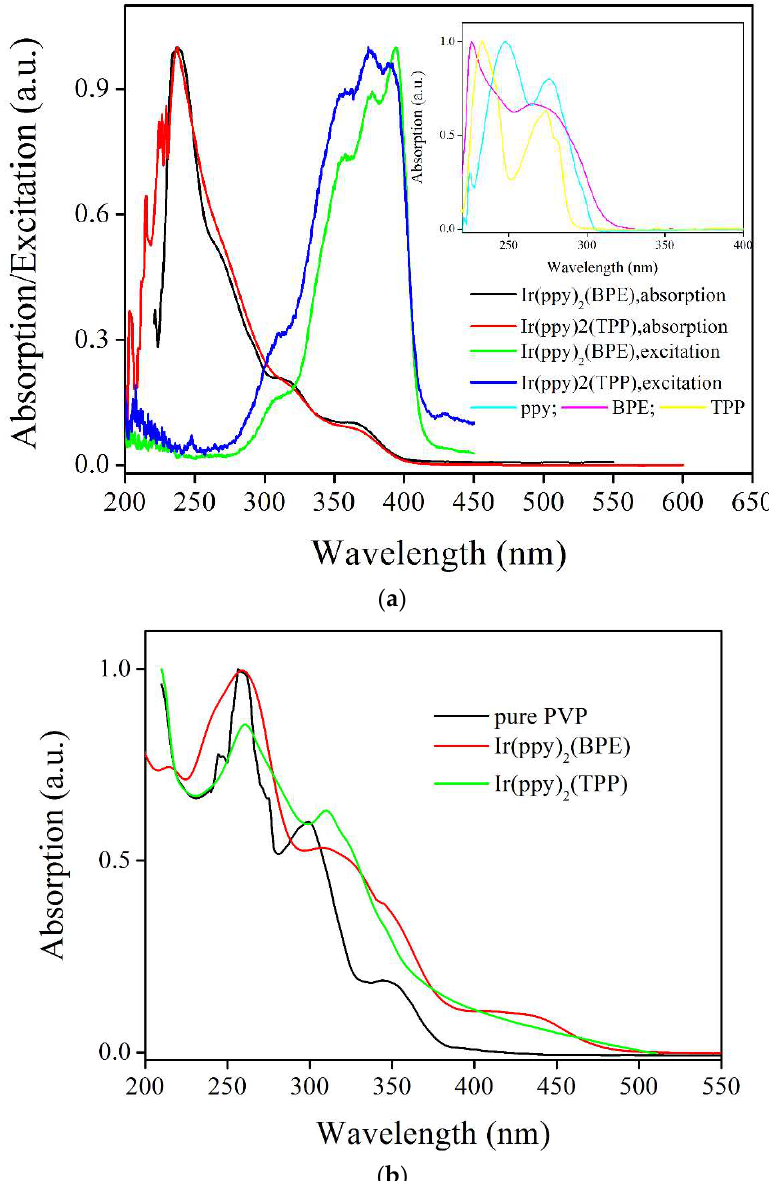
Figure 3. ( a ) Absorption and excitation spectra of Ir(ppy) 2 (BPE) and Ir(ppy) 2 (TPP) in CH 2 Cl 2 solution (1 μM). Inset: absorption spectra of ligands in CH 2 Cl 2 solution (1 μM); ( b ) Absorption spectra of pure PVP, Ir(ppy) 2 (BPE)- and Ir(ppy) 2 (TPP)-doped PVP fiber (10%). Regardless of the weak absorption of the MLLCT transition (369 nm), it was highly effective in exciting the emissive centers of Ir(ppy) 2 (BPE) and Ir(ppy) 2 (TPP), as shown in